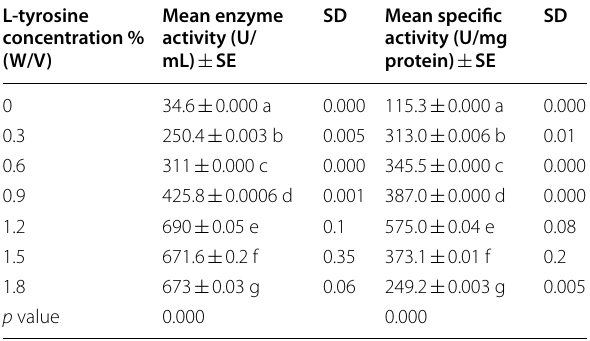
Table 2 Effect of tested concentrations of L-tyrosine on the production of tyrosinase